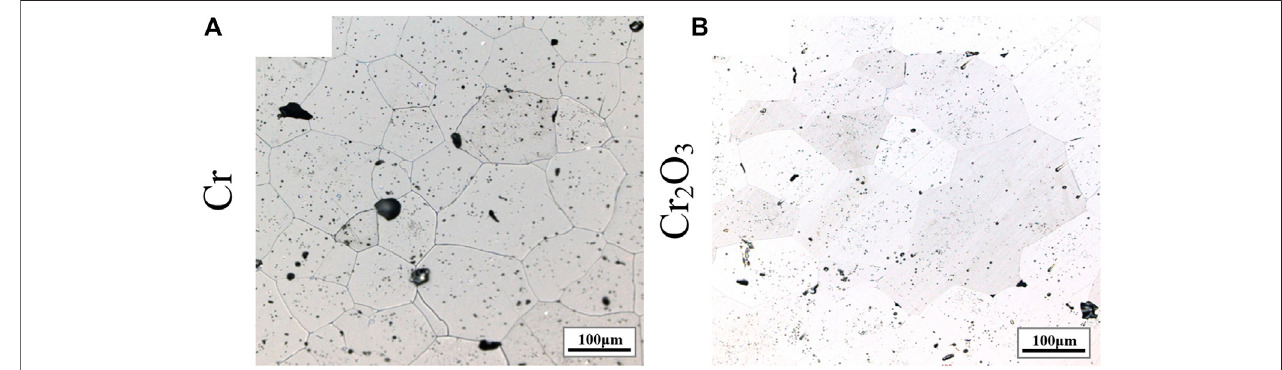
FIGURE 9 | Grain morphologies of the sample used in the TD and CTE test.